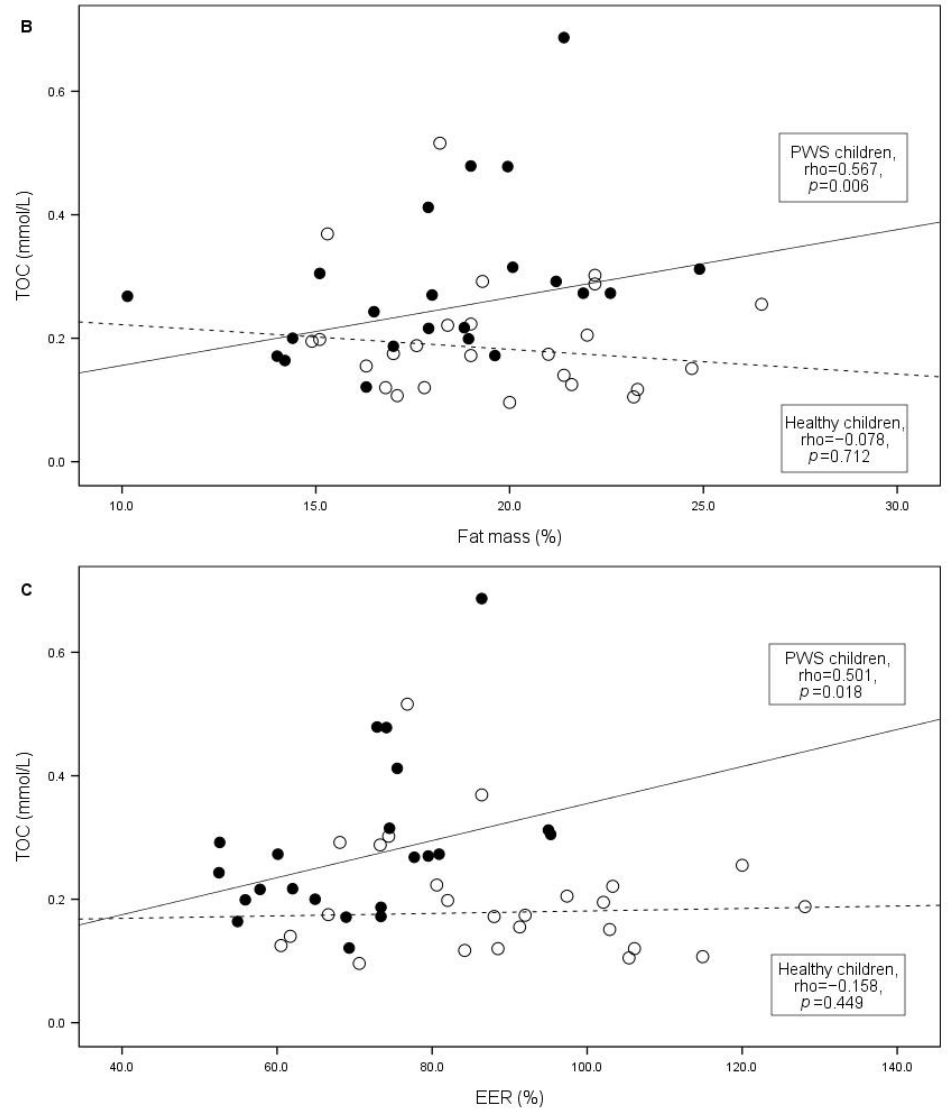
Figure 1. TOC values and BMI Z-score ( A ), fat mass percentage ( B ), and EER percentage ( C ) in children with PWS and controls. Black circles—PWS children, white circles—healthy children. Lines represent quantile regression. Positive associations were also found between TOC values and percentage of fat mass ( ρ = 0.567; p = 0.006) and percentage of EER ( ρ = 0.501; p = 0.018) in children with PWS (Figure 1B,C). These associations were not observed in the control group. We also found positive associations between TAC values and fiber intake ( ρ = 0.438; p = 0.042) in patients with PWS (Figure